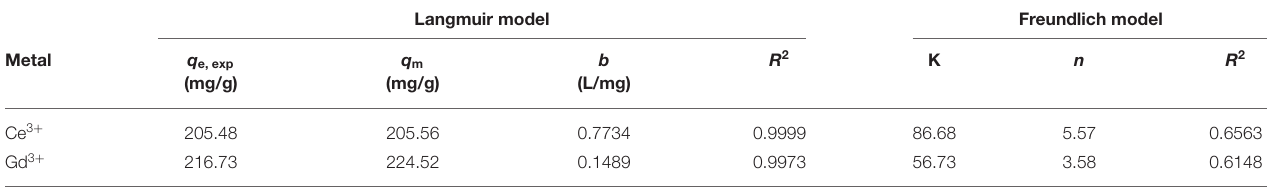
TABLE 3 | Adsorption isotherm constants of Ce(III) and Gd(III) onto CMC- g -PAM/ATP.